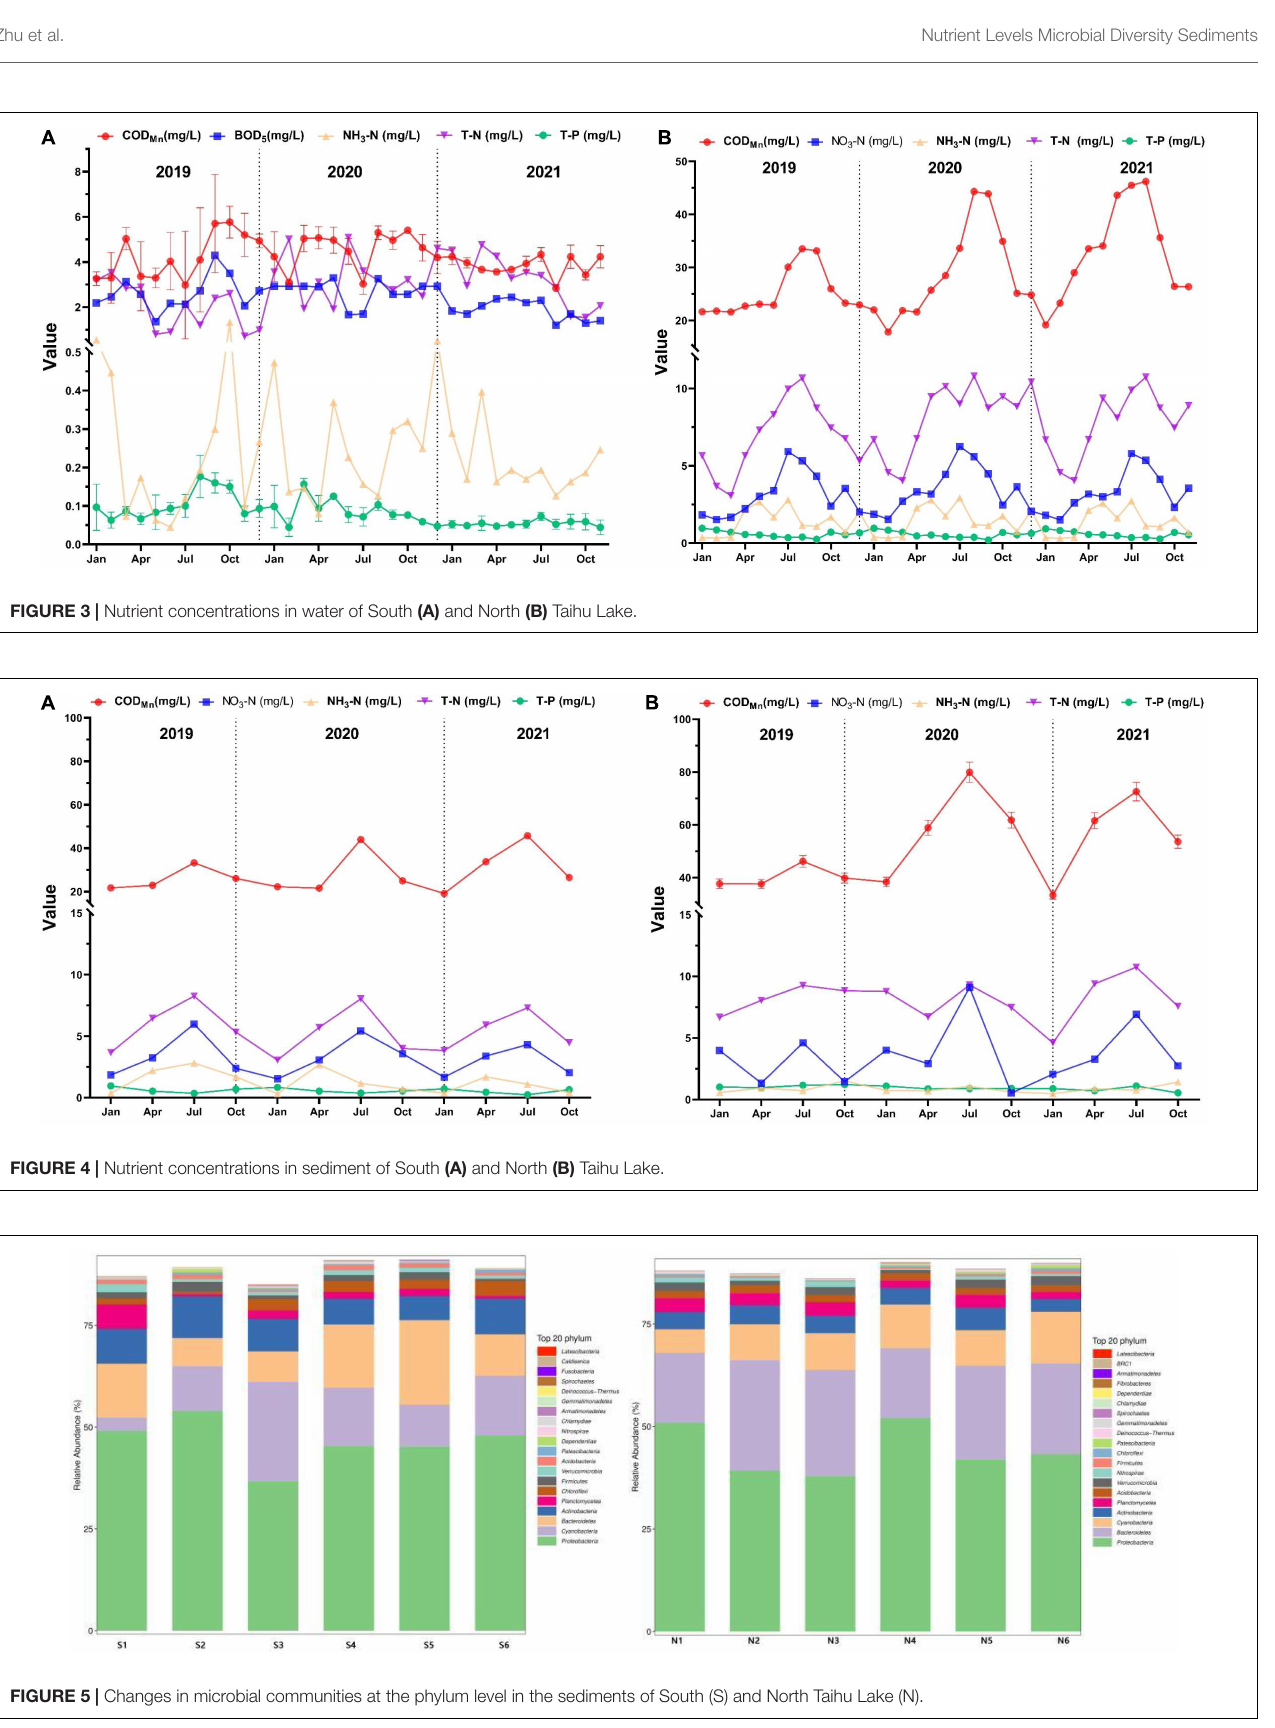
Frontiers in Ecology and Evolution |